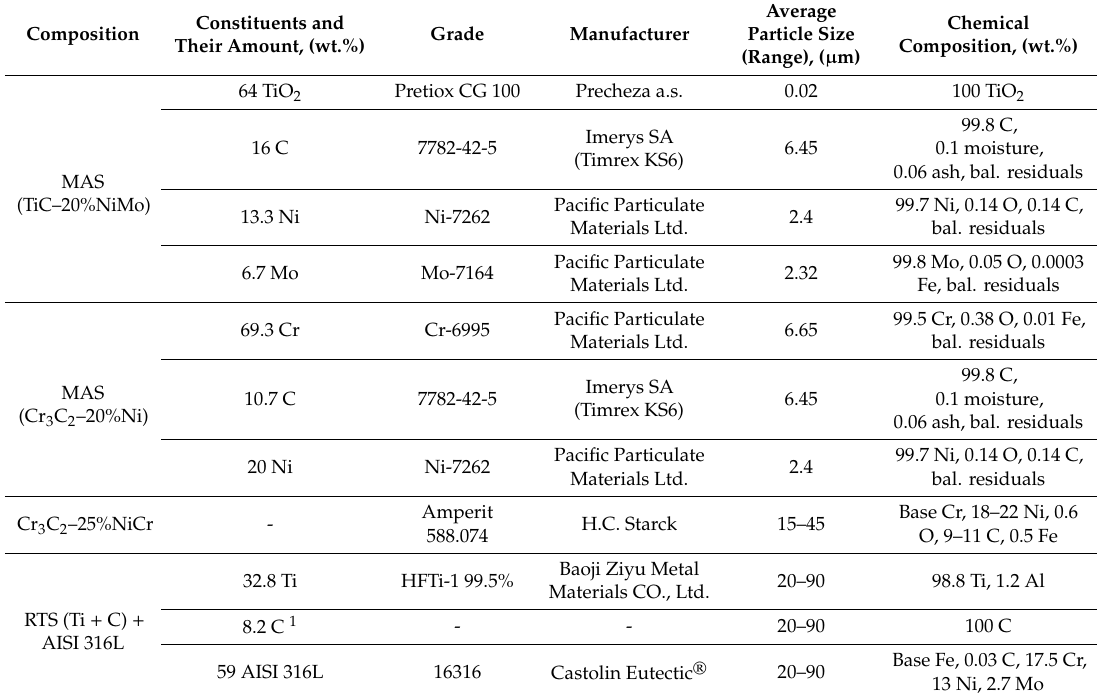
Table 1. Chemical composition and the amounts of constituents in the spraying powders.